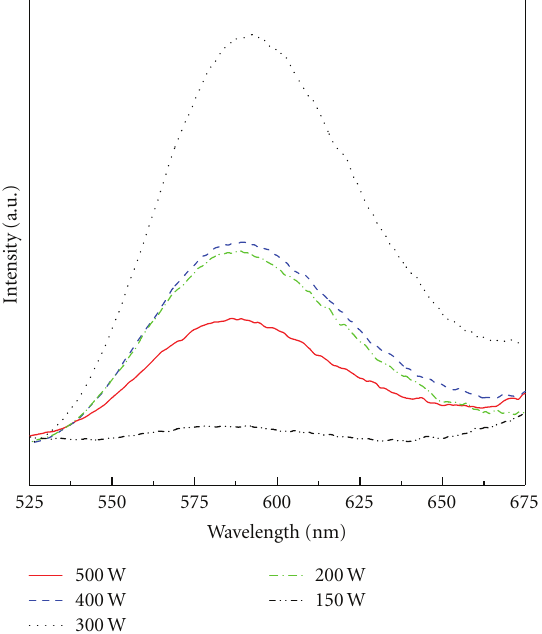
Figure 5: Photoluminescence emission spectra of 2-ethylhexanoic acid-coated ZnS:Mn 2+ nanoparticles prepared using di ff erent microwave power. The spectra are recorded under the excitation of 325nm